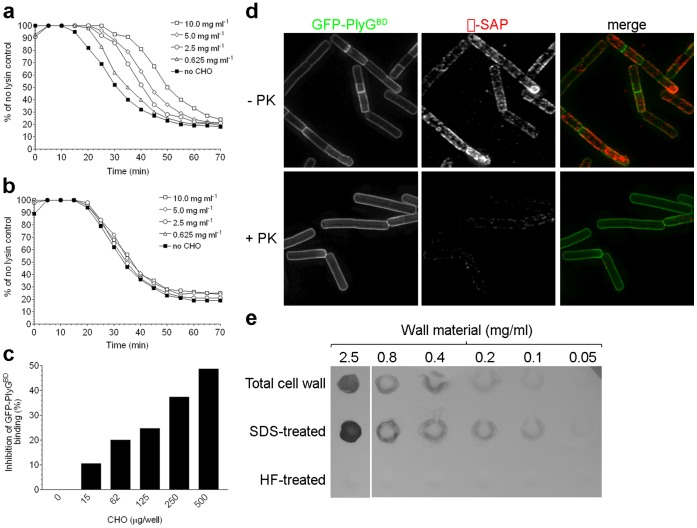
Interaction of PlyG with B. anthracis NPS.(A) Dose-dependent inhibition of PlyG lytic activity after pre-incubation with B. anthracis NPS. (B) PlyG activity after pre-incubation with increasing amounts of the CWG from Streptococcus pyogenes. (C) Dose-dependent inhibition of PlyGBD surface-binding after pre-incubation with B. anthracis NPS. (D) Deltavision images of surface-labeled B. anthracis with or without proteinase K treatment (+/−PK). NPS (green) was labeled with GFP-PlyGBD, and the S-layer Sap protein (red) was labeled with specific antibodies and an Alexa Fluor 647-conjugated secondary antibody. (E) Dot-blot analysis of PlyGBD binding to total cell wall material and both SDS-treated and HF-treated walls.